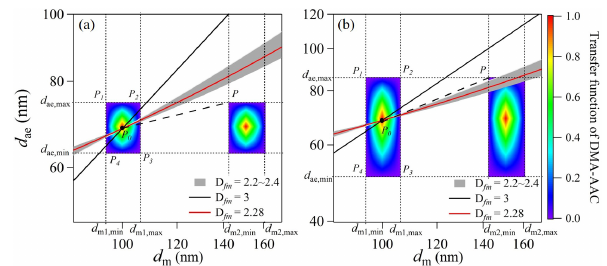
Figure 4. Examples of transfer function calculation of DMA– AAC of flame-generated soot particles (Pei et al., 2018). The following parameter set was employed for the calculations: Q a = 0 . 3Lmin − 1 , d m1 = 100nm and d ae = 68 . 3nm, as well as (a) β DMA = 0 . 1 and β AAC = 0 . 1 and (b) β DMA = 0 . 1 and β AAC = 0 . 3. The color blocks are the transfer functions of DMA–AAC. The solid black and red lines are particle populations with D fm values of 3 and 2.28, respectively. The gray region is the particle population with D fm of 2.2–2.4, which is typical for soot aerosol. The dashed line is the critical slope of PP 0 . The dotted lines are the limiting d m and d ae of DMA and AAC,